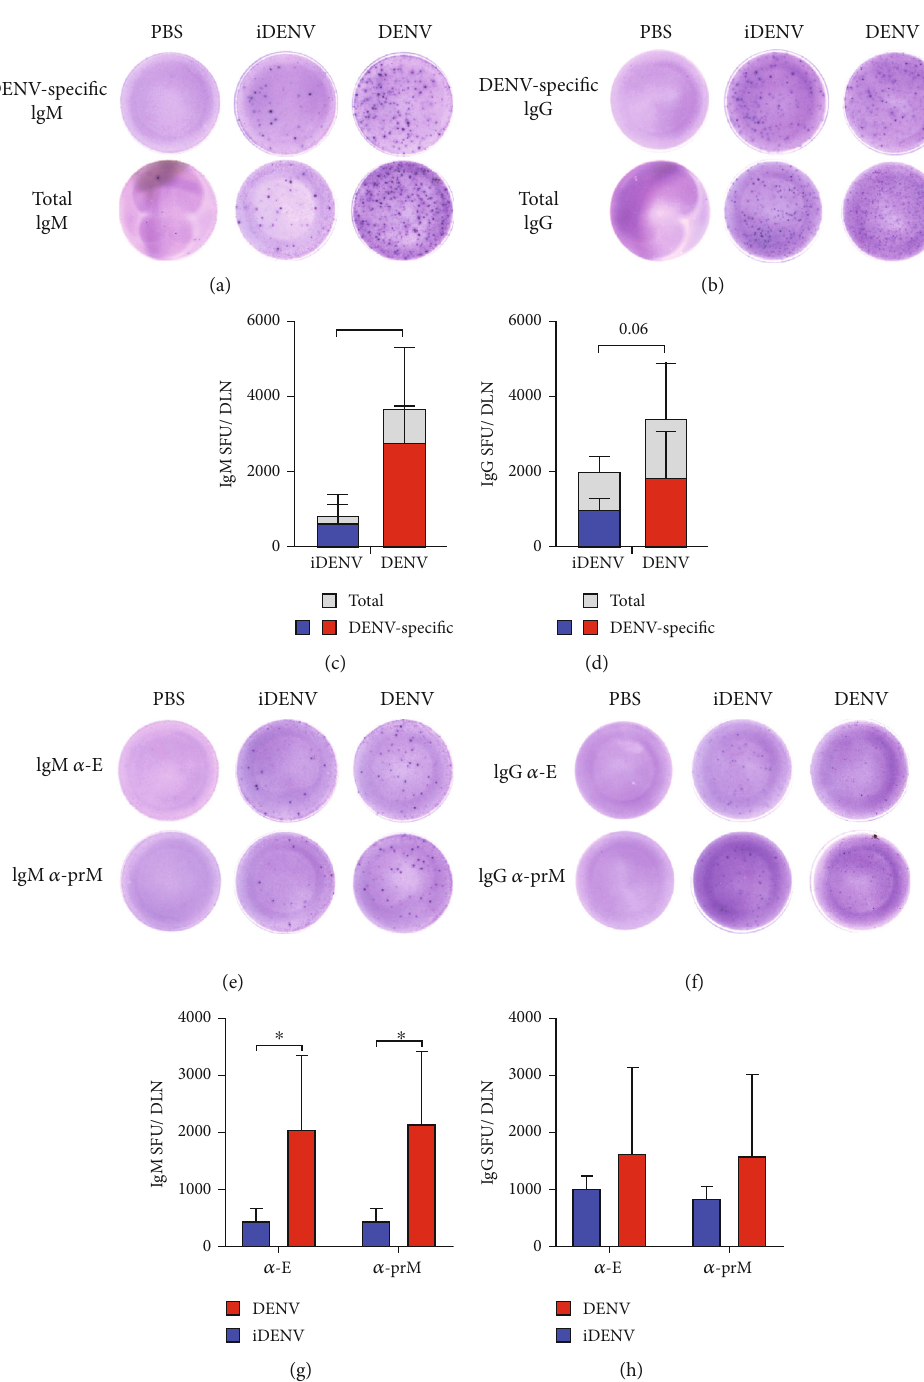
Figure 3: PCs speci fi c to DENV and structural E and prM proteins. ELISPOT assays of DENV-, E-, and prM-IgM and -IgG PCs were performed at day 10 postinoculation. Representative pictures of wells for the detection of total or DENV-speci fi c IgM (a) and IgG SFU (b). Graphs showing the number of total and DENV-speci fi c IgM (c) or IgG SFU (d) per DLN. Representative pictures of wells detecting E- and prM-speci fi c IgM (e) or IgG SFU (f). Graphs showing the number of E- and prM-speci fi c IgM (g) or IgG SFU (h). Data shown represent the mean ± SD of one experiment with 4 mice per group. Data were analyzed with the Mann – Whitney U test. ∗ P < 0 : 05